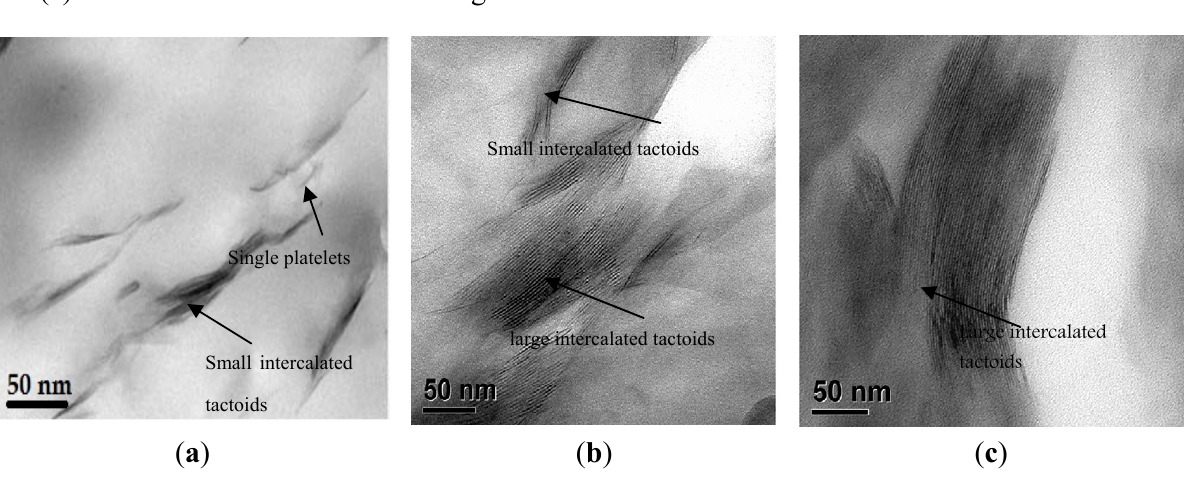
Figure 1. Transmission electron microscopy (TEM) micrographs of dispersied nanoclay particles for ( a ) 2 wt.% magnetic + 3 roll milling; ( b ) 3 wt.% magnetic + 3 roll milling; ( c ) 3 wt.% sonication + 3 roll milling.